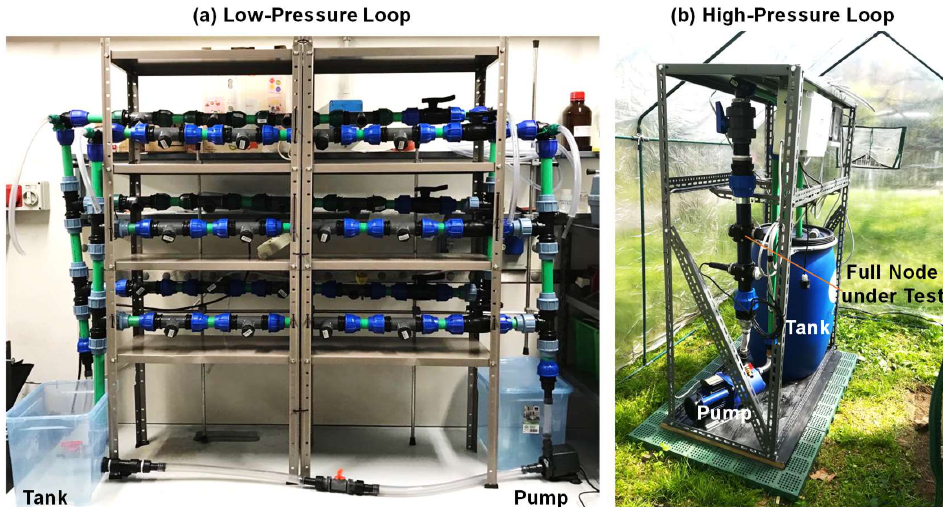
Figure 6. Laboratory setups for dynamic and continuous characterization of the sensors in the hydraulic loop with controlled conditions of temperature, flow, chemical concentration, and pressure: up to 4 bar